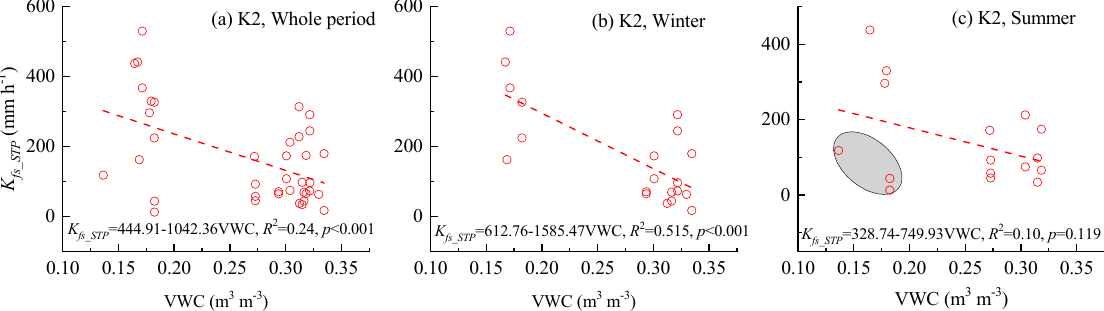
Figure 8. Relationships between antecedent soil volumetric water content (VWC) and viscosity-corrected field-saturated hydraulic conductivity ( K fs_STP ) at K2 during the entire study duration ( a ), in the winter ( b ), and in the summer ( c ). The shaded region in ( c ) encompasses notably low K fs values with the low soil VWC in the summer (included in the regression).